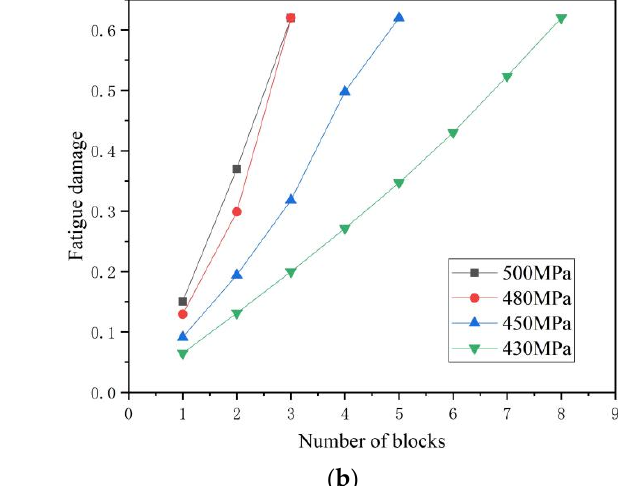
Figure 8. Effect of the stress level on fatigue damage of stress block: ( a ) the high stress for 10 cycles with 450 MPa/2 × 10 5 cycles; and ( b ) the low stress for 2 × 10 5 cycles with 950 MPa/10 cycles.